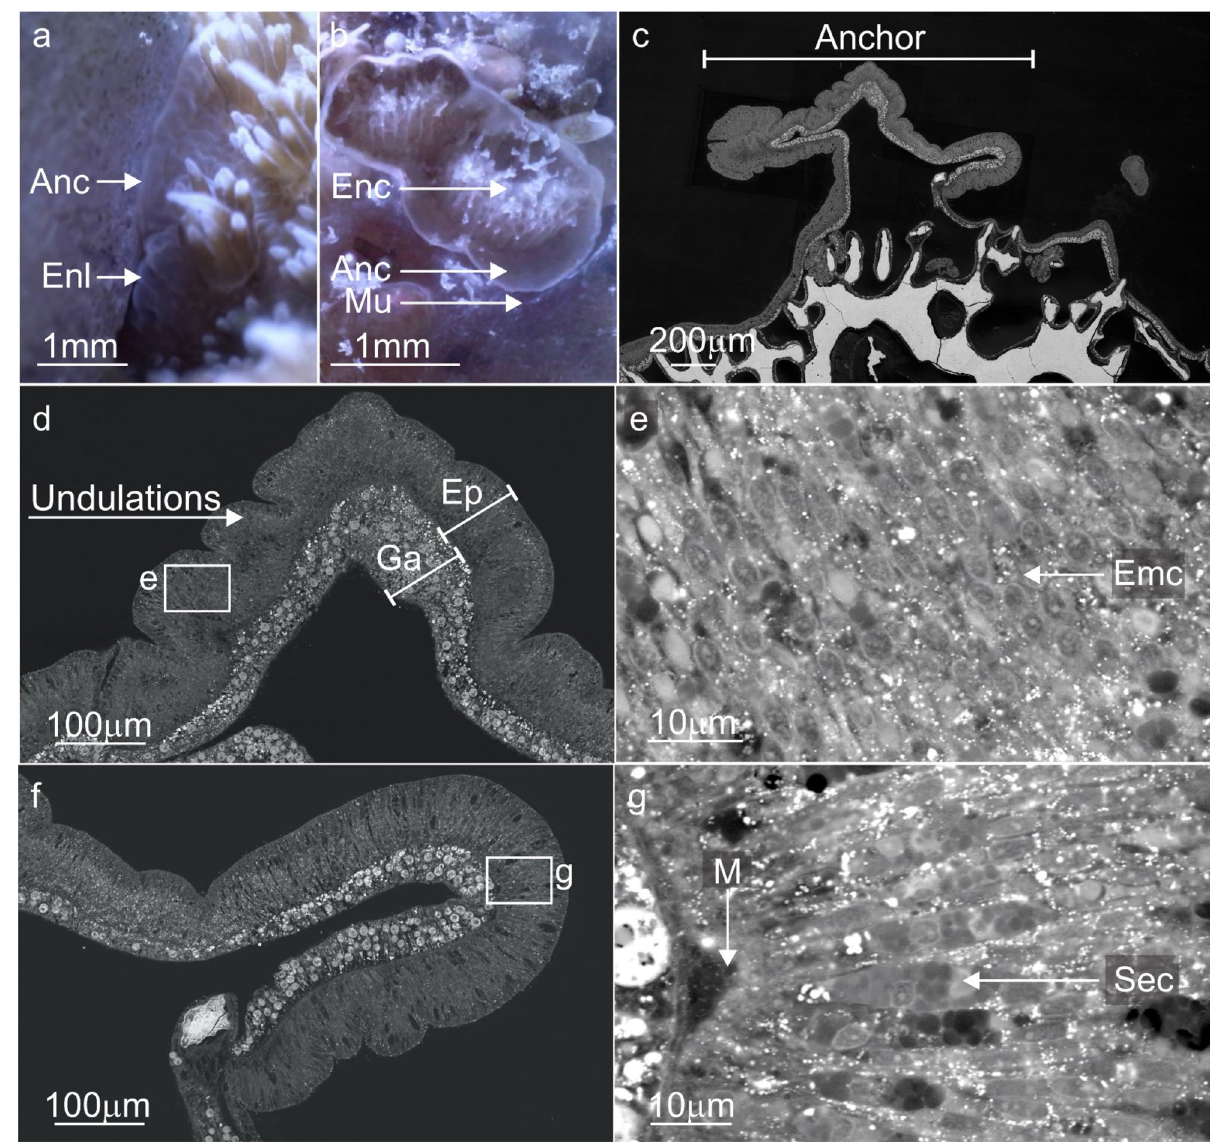
Figure 5. Backscatter electron microscopy images and stills from time-lapse microscopy movies comparing A. millepora’ ’s regular tissues with the enlarged anchored tissues. ( a ) The enlarged tissues (Enl) from phase one develop into a that anchors and helps stabilise the fragment. ( b , c ) The anchoring process creates a sealed or enclosed (Enc) environment where the SBW or epidermis can be safely removed and a BBW can form. ( d , e ) The anchoring tissue took on a complex undulated morphology that likely assists tissue anchoring. The shifting morphology of these tissues is down to an ongoing proliferation of supporting cells which also act as epitheliomuscular cells (Emc) and ( f , g ) gland cells (Sec), which may also aid with adhesion. Enlarged tissues; Enl, soft tissue attachment; Anc, enclosed environment; Enc, epidermis; Ep, gastrodermis; Ga, mesoglea; appendage appears discoloured or lighter than the surrounding tissues, is polyp free and enlarged compared to the standard coenosarc (Fig. 7a,b). The lappet-like appendage was capable of systematic pulsed contractions or undulations that circulated around the encrusting rim where the lappet-like was present (Supplementary Movie S5). Micro anatomy. Tissue cross-sections identified that 4 distinct features characterise the lappet-like appendage: (1) a larger than usual surface body wall epithelia, (2) a transition zone where the cells of the epidermis shift towards those of the calicodermis, (3) an undulated base (Fig. 7c,d) and (4) a unique, non-intrusive (< 5 µm), poorly defined calicodermal epithelium which extends from the transition zone and lies under the undulations and initial skeleton that formed on the substrate (Fig. 7e). The lappet-like epidermis contains three cell types; myofibrous epithelial supporting cells, gland cells (some of which are autofluorescent), and nematocysts (Fig. 8). The gastrodermis also contains increased supporting cells but has fewer Symbiodiniaceae than the regular coe-